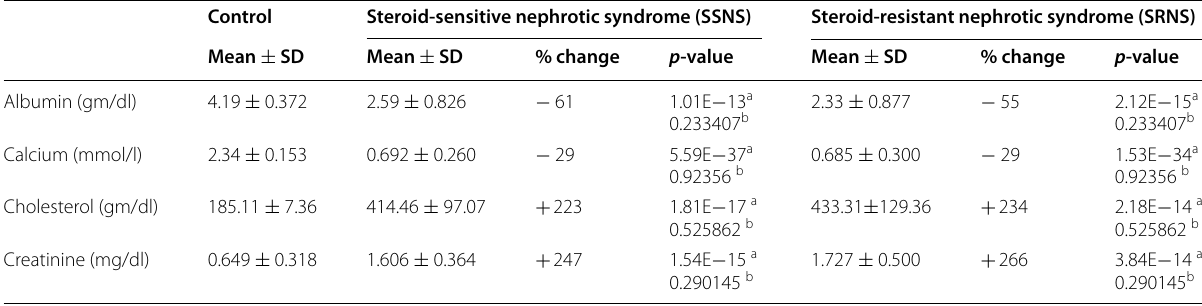
Statistical significance was evaluated by t -test with p -values < 0.05 The p -value represented by a and b a All NS patients were compared with normal healthy individuals b Comparison of SSNS with SRNS in each group